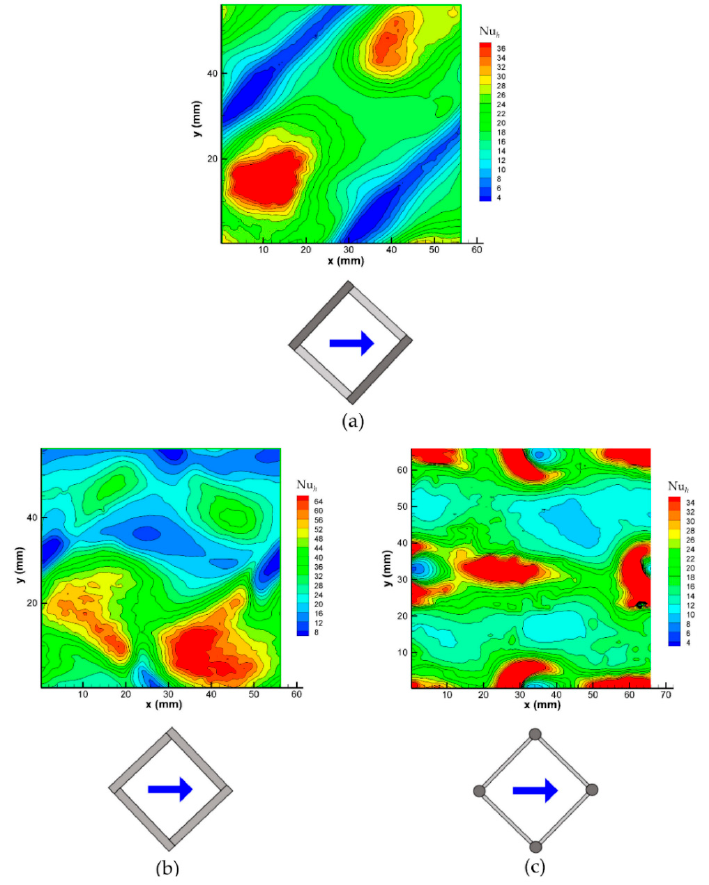
Figure 11. Distributions of the local Nusselt number on a wall for different spacer configurations at a Reynolds number of ~500 and a flow attack angle of 45°. ( a ) Overlapped spacer; ( b ) woven spacer; ( c ) spheres spacer.